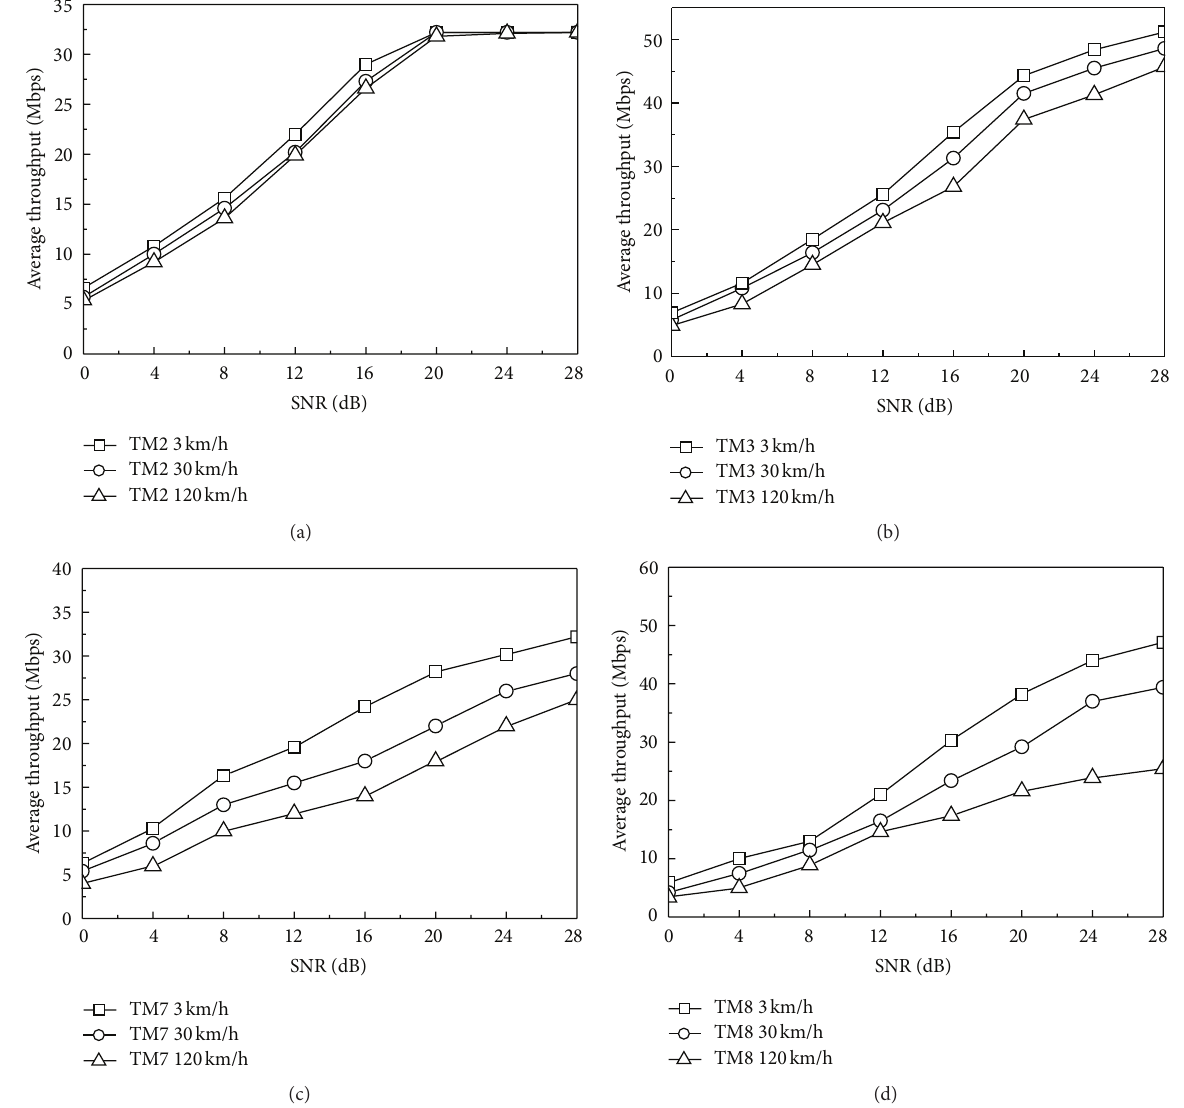
Figure 5: The average throughput for SCME based on the indoor